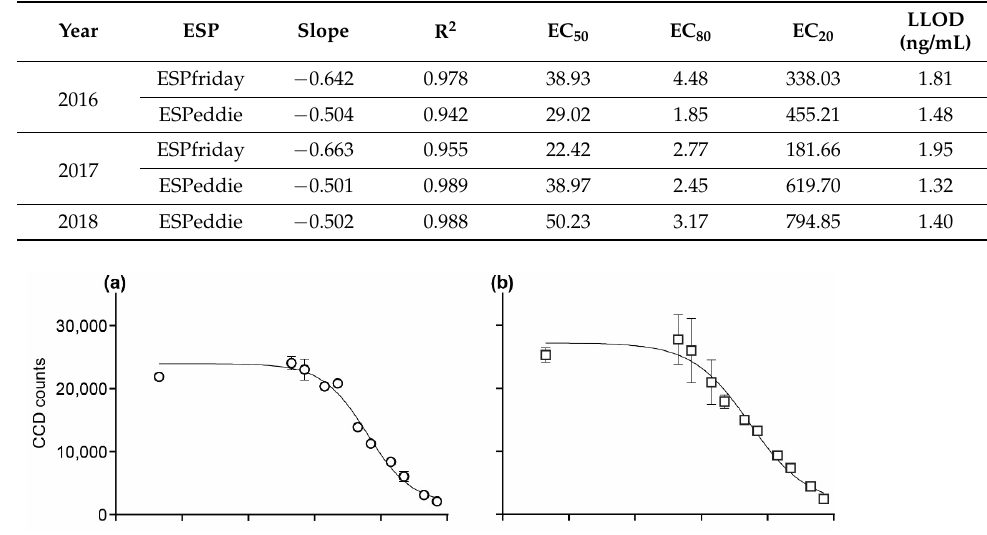
Figure 5. Domoic acid (DA) calibration curves for ESPfriday and ESPeddie in 2016, 2017, and 2018: ( a ) 2016 ESPfriday; ( b ) 2016 ESPeddie; ( c ) 2017 ESPfriday; ( d ) 2017 ESPeddie; and ( e ) I 2018 ESPeddie. Each point on the curve is the average spot intensity from 2 DA arrays (± SD). Parame- ters describing each curve are given in Table 2. Table 2. Parameters for the domoic acid (DA) calibration curves on ESPfriday and ESPeddie in 2016, 2017, and 2018. Parameters are determined based on a 4-parameter logistic fit (variable slope) of signals generated by DA certified reference material tested at 10 concentrations ranging from 0.2 to 5000 ng/mL, as well as a 0 ng/mL negative ( n = 2 for all values). The EC 50 represents the half-maximal response, whereas the EC 80 and EC 20 represent the lower and upper limits or bound- aries, respectively, of the linear dynamic range within which responses can be quantified accu- rately (i.e., LLOQ and ULOQ). The lower limit of detection (LLOD) refers to the lowest toxin con- centration (ng/mL) that can be detected but not quantified reliably (see text for additional details). Year